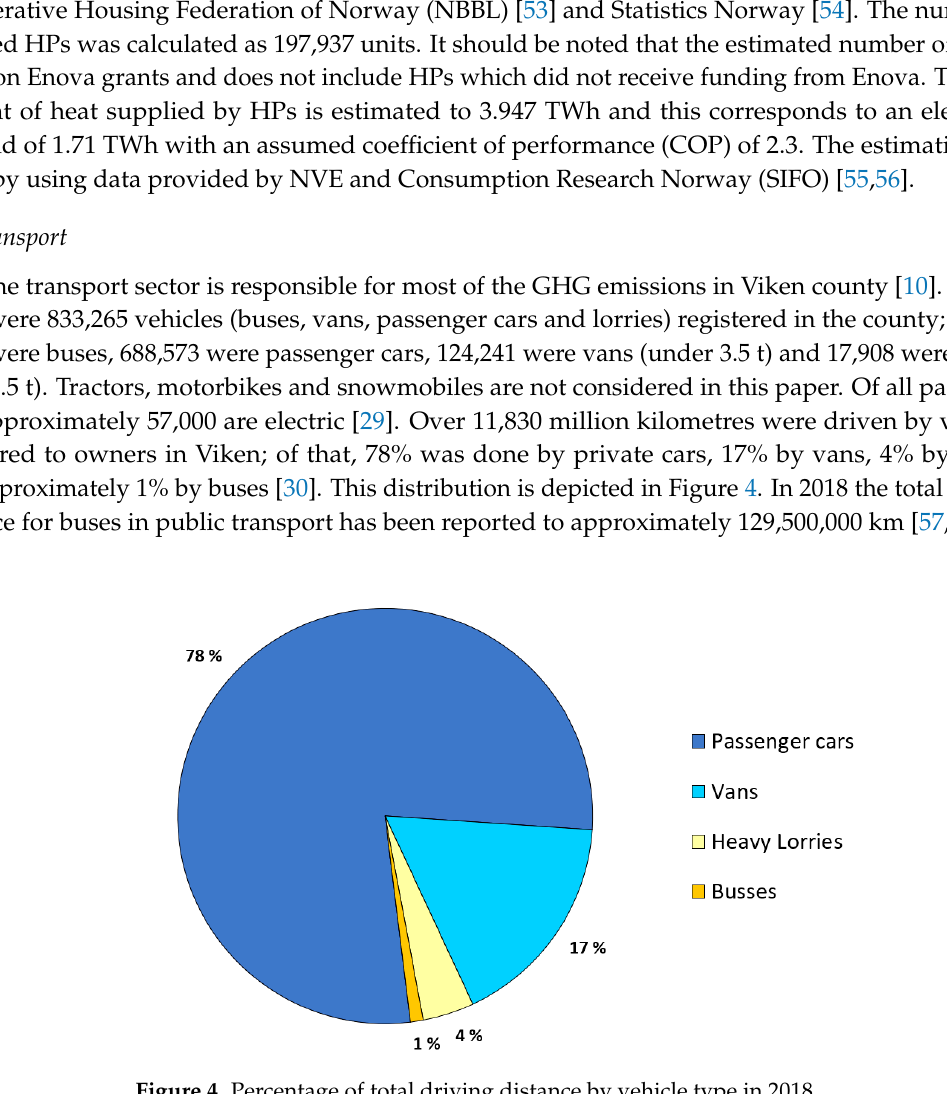
Figure 4. Percentage of total driving distance by vehicle type in